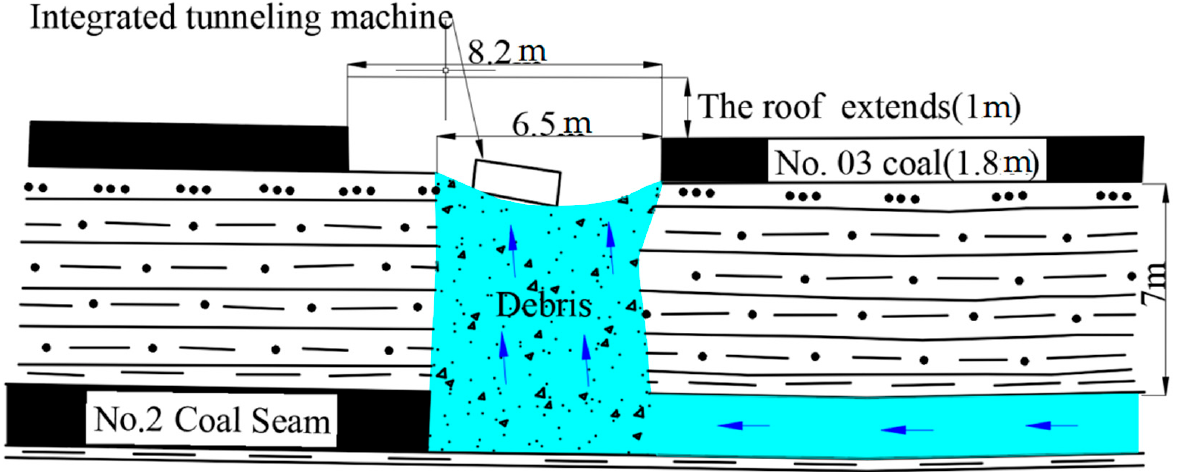
Figure 8. Section diagram of the water inrush position perpendicular to the excavation direction. According to the geological data and borehole data, five boreholes were drilled at the cut opening and 60 m away from the cut opening, respectively, two of which were boreholes in the direction of the floor. The stratum structure and thickness of coal seams No.3 and No.2 were obtained (Figure